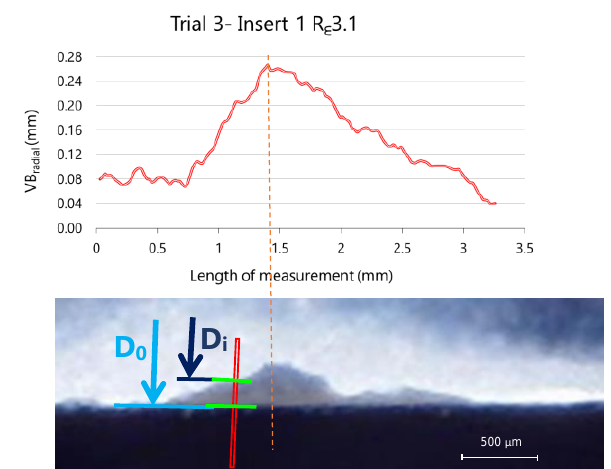
Figure 15. Measured VB radial of insert 2 during trial 3 (removed volume 13.9 × 10 4 mm 3 ) and two overlapping images of radial flank: reference insert (background) and worn insert (first plane).